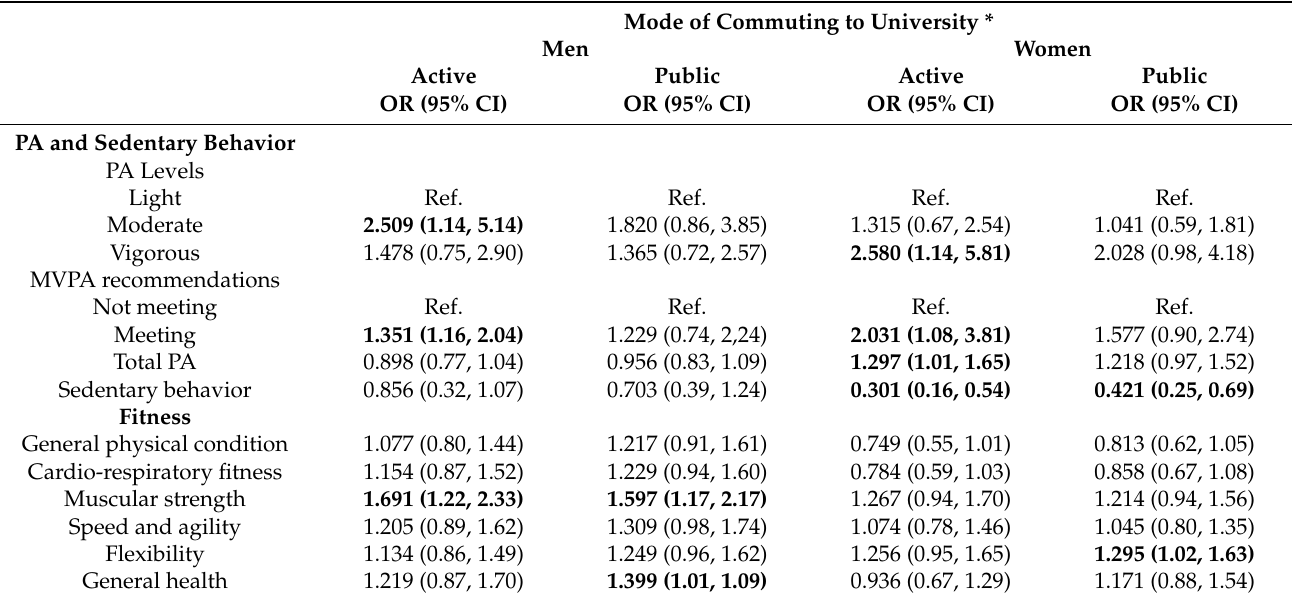
Table 2. Associations of mode of commuting with PA, sedentary behavior and fitness of the partici- pants by gender.